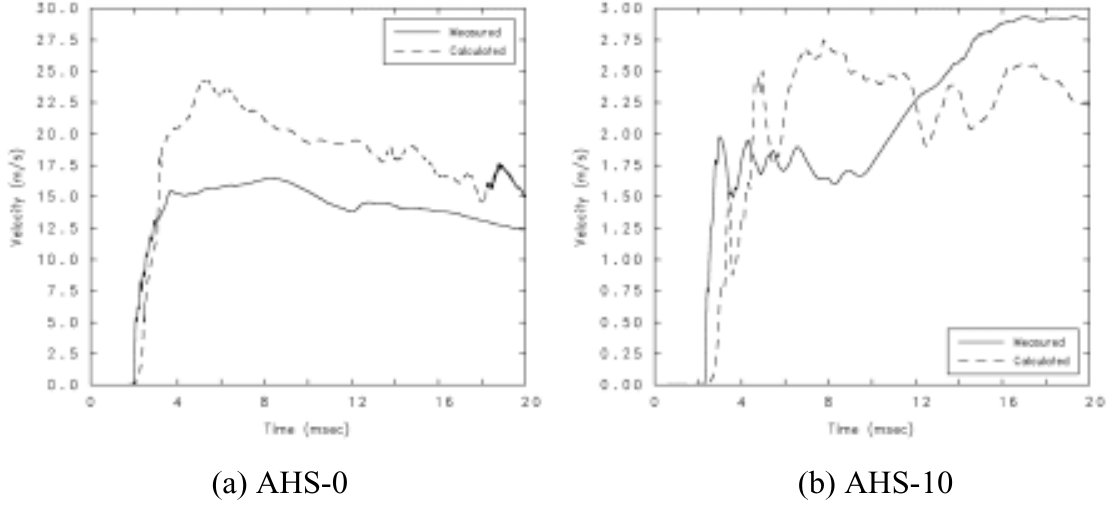
Fig. 6. Typical results.